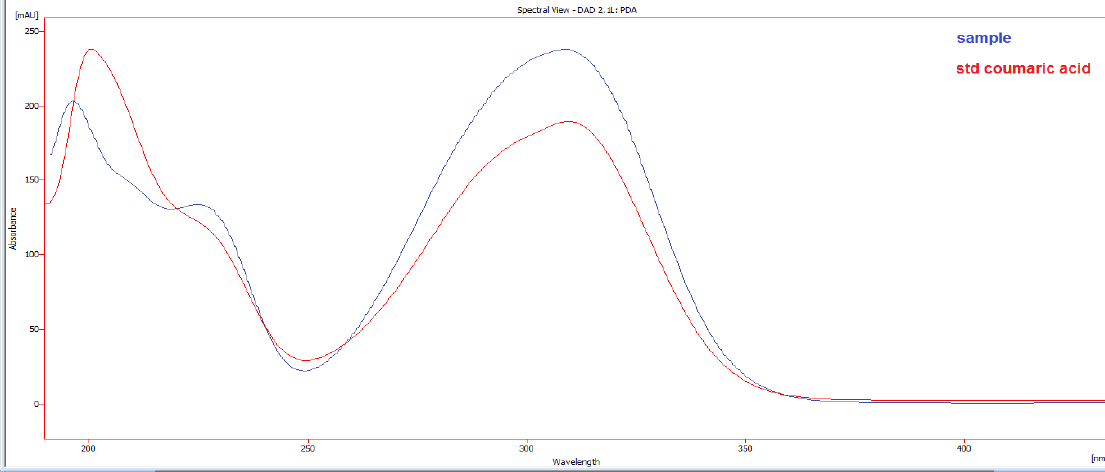
Figure 9. UV spectrum of standard coumaric acid and isolated cpd C4 FTIR